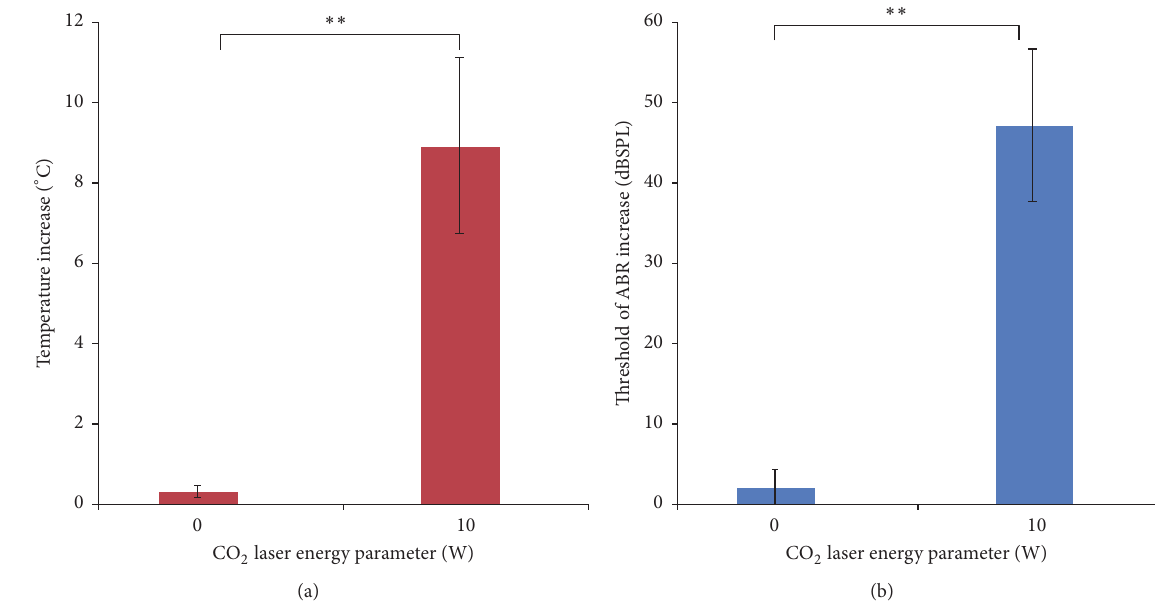
Figure 2: The temperature increase during surgery and mean incremental rise in the ABR threshold immediately after surgery by CO 2 laser irradiation (10W laser and control groups). (a) The temperature rise in the 10W CO 2 laser group was much higher than in the control group ( 𝑃 < 0.01 ). Data are presented as means + standard deviation (SD), 𝑛 = 21 , ∗∗ 𝑃 < 0.01 . (b) ABR threshold rise immediately after laser irradiation was higher in the 10W laser group than the 0W laser group ( 𝑃 < 0.01 ). Data are presented as means + SD, 𝑛 = 21 , ∗∗ 𝑃 < 0.01